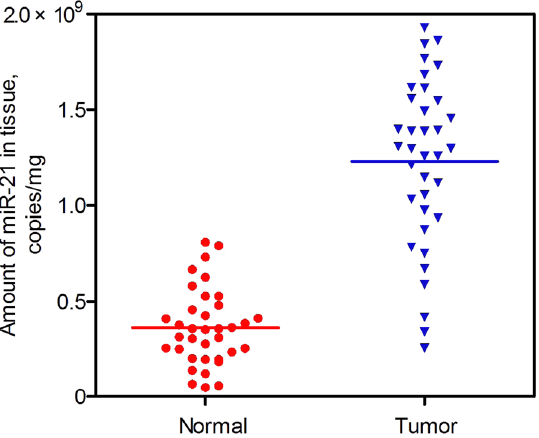
Figure 8. Quantification of miR-21 in 36 matched pairs of breast tissue samples using quasi-direct targeted proteomics